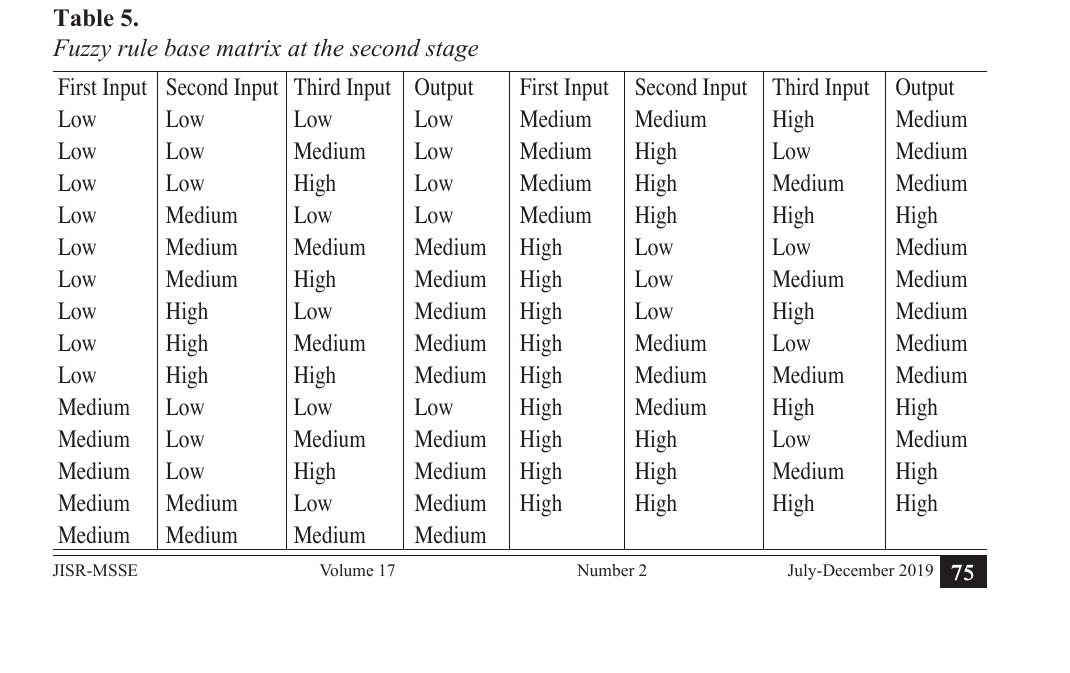
Fuzzy rule base matrix at the second